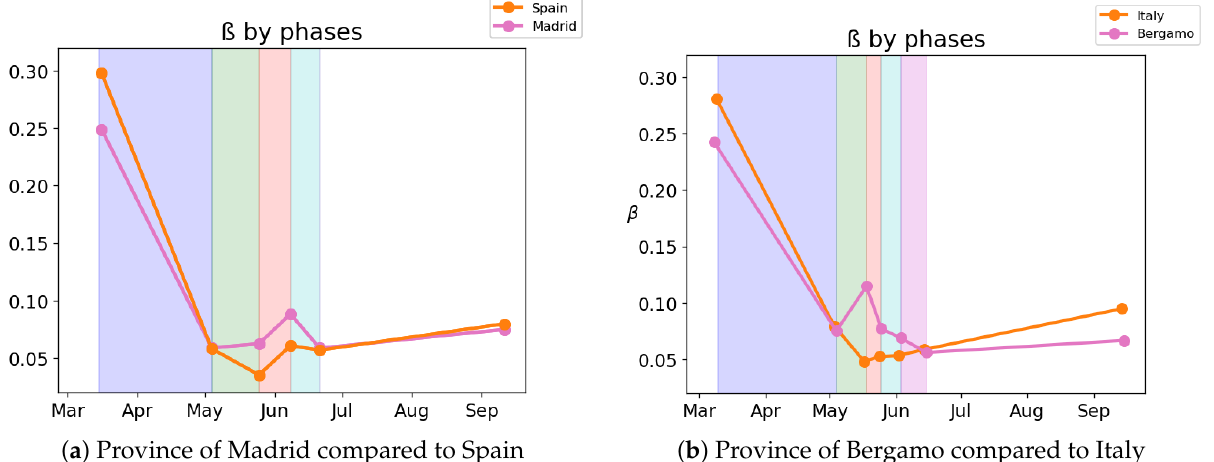
Figure 10. A comparison between the β of the different stages in Spain and